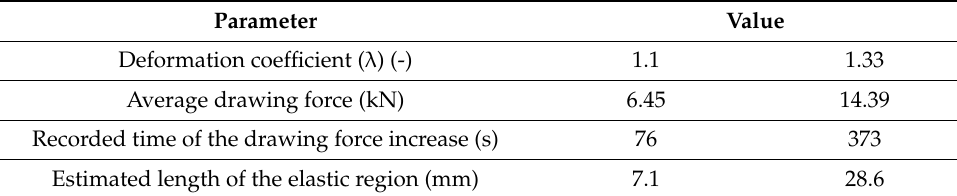
Table 5. Estimated lengths of the elastic deformation region based on the measured drawing force (average values) during the wire drawing process with the velocity of 0.1 mm/s and deformation coefficients of 1.1 and 1.33 .